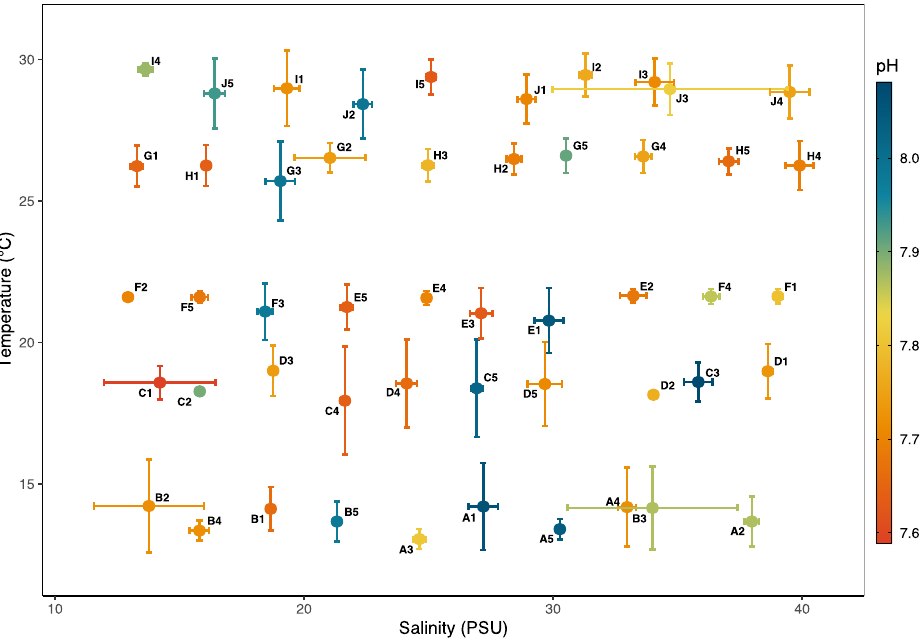
Figure 2. Average treatment values of culture cups in the experiment. X and Y axes represent mean salinity and temperature, color represents average pH. Error bars represent standard deviation of temperature and salinity for the duration of the cup’s inclusion in the experiment (3–17 days). Average standard deviation of salinity was ± 0.59 PSU, temperature was ± 0.83 °C, and pH was ± 0.03 pH